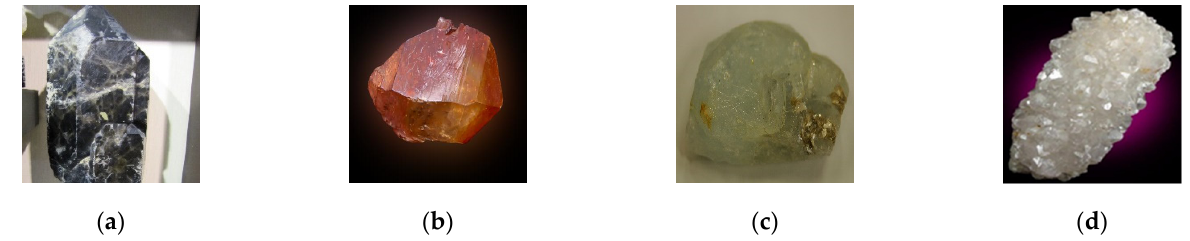
Figure 6. Misrecognized examples of quartz photo images in dataset-1. ( a – d ) are misrecognized as muscovite, garnet, beryl, and calcite respectively.